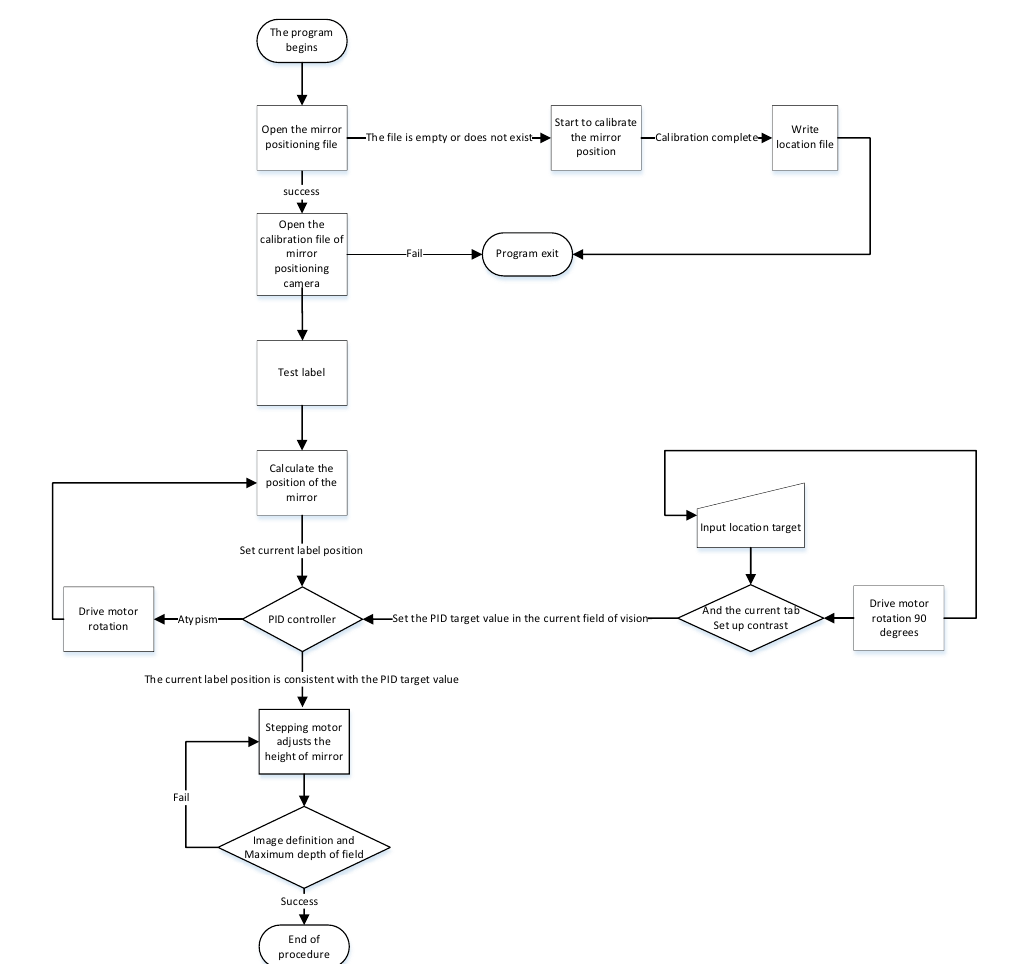
Figure 6. Feasible flow chart of visual positioning module.